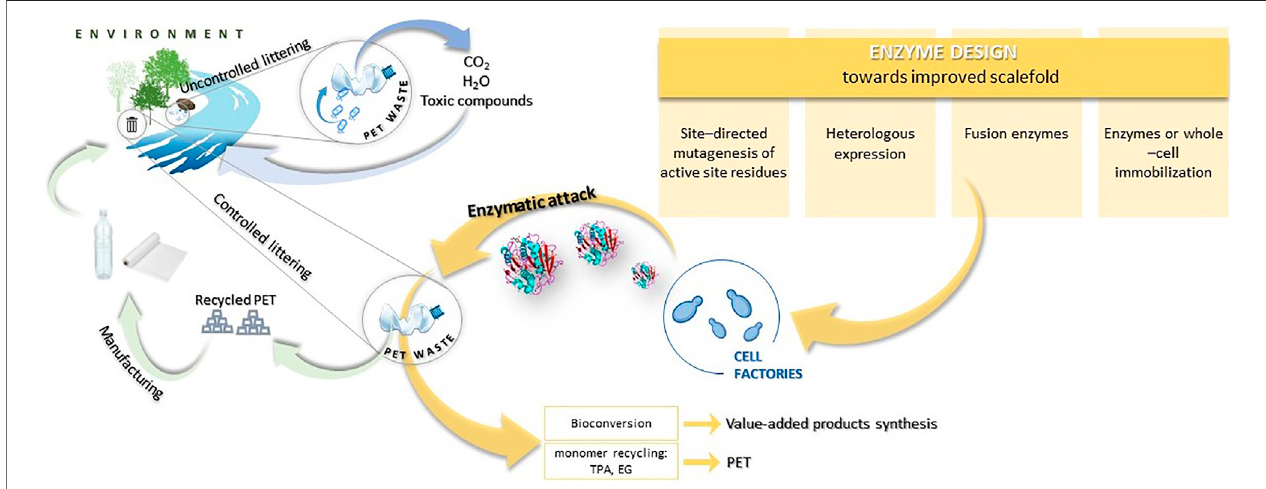
FIGURE 1 | Scheme of plastic circulation in the natural environment and the possibilities of the plastic circular economy.